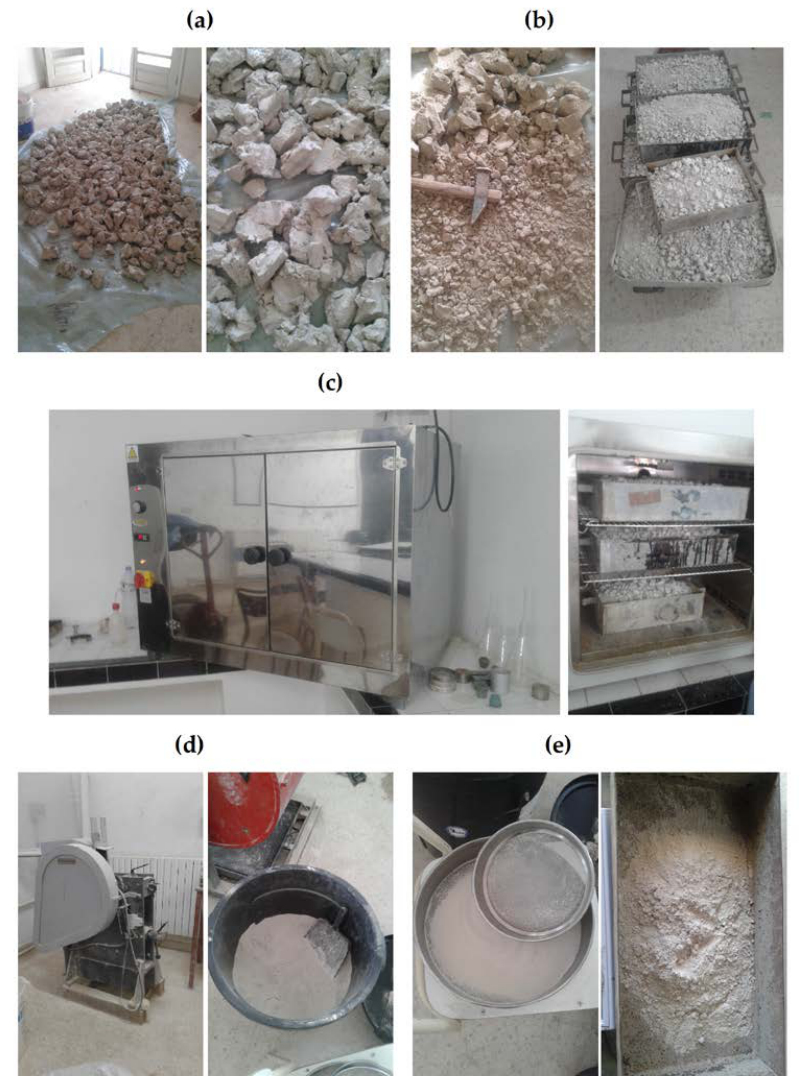
Figure 2. Different steps of marble powder preparation: ( a ) Air drying of marble sludge, ( b ) Crushing of marble sludge, ( c ) Drying of marble sludge in oven, ( d ) Grinding of marble sludge, ( e ) Sieving of marble powder